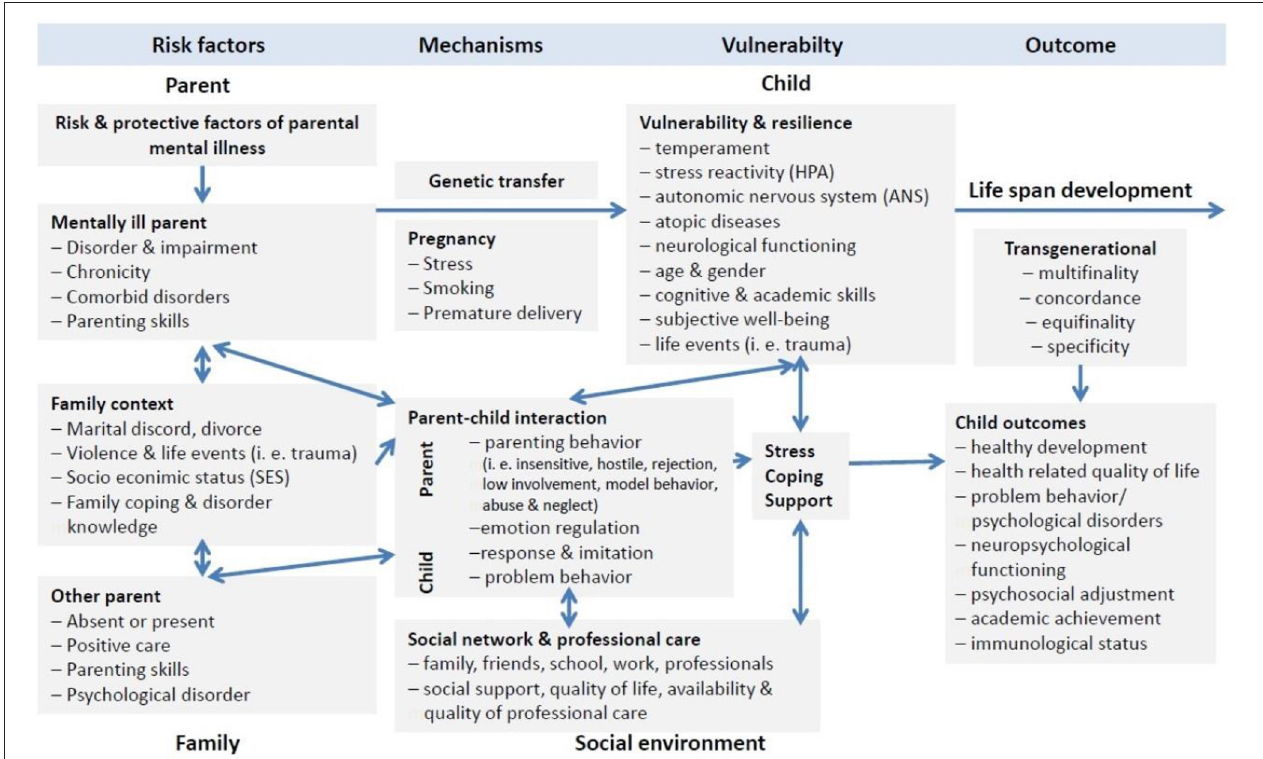
FIGURE 1 | Model of transgenerational transmission of mental illness adapted from Hosman et al. (9) and Christiansen et al.